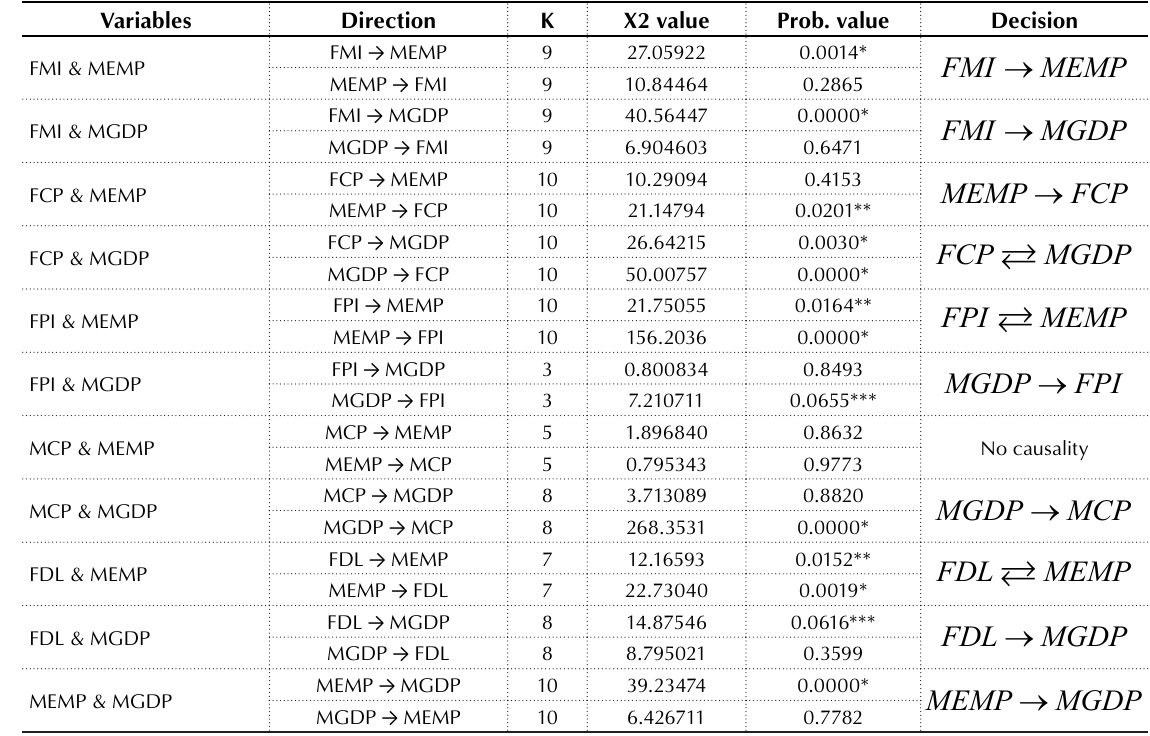
Table 3. Causality